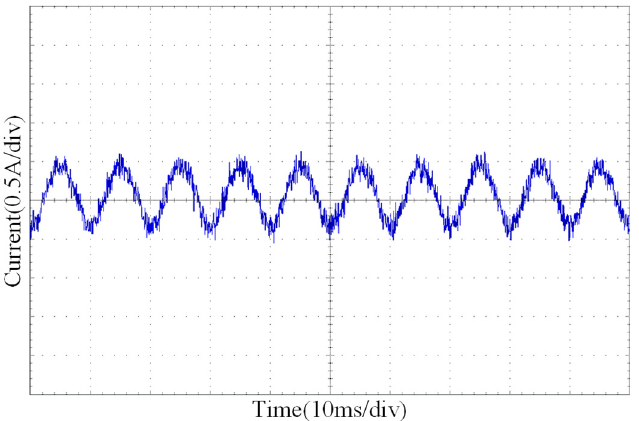
Figure 18. Input voltage and current waveform of bridgeless PFC with power decoupling circuit.